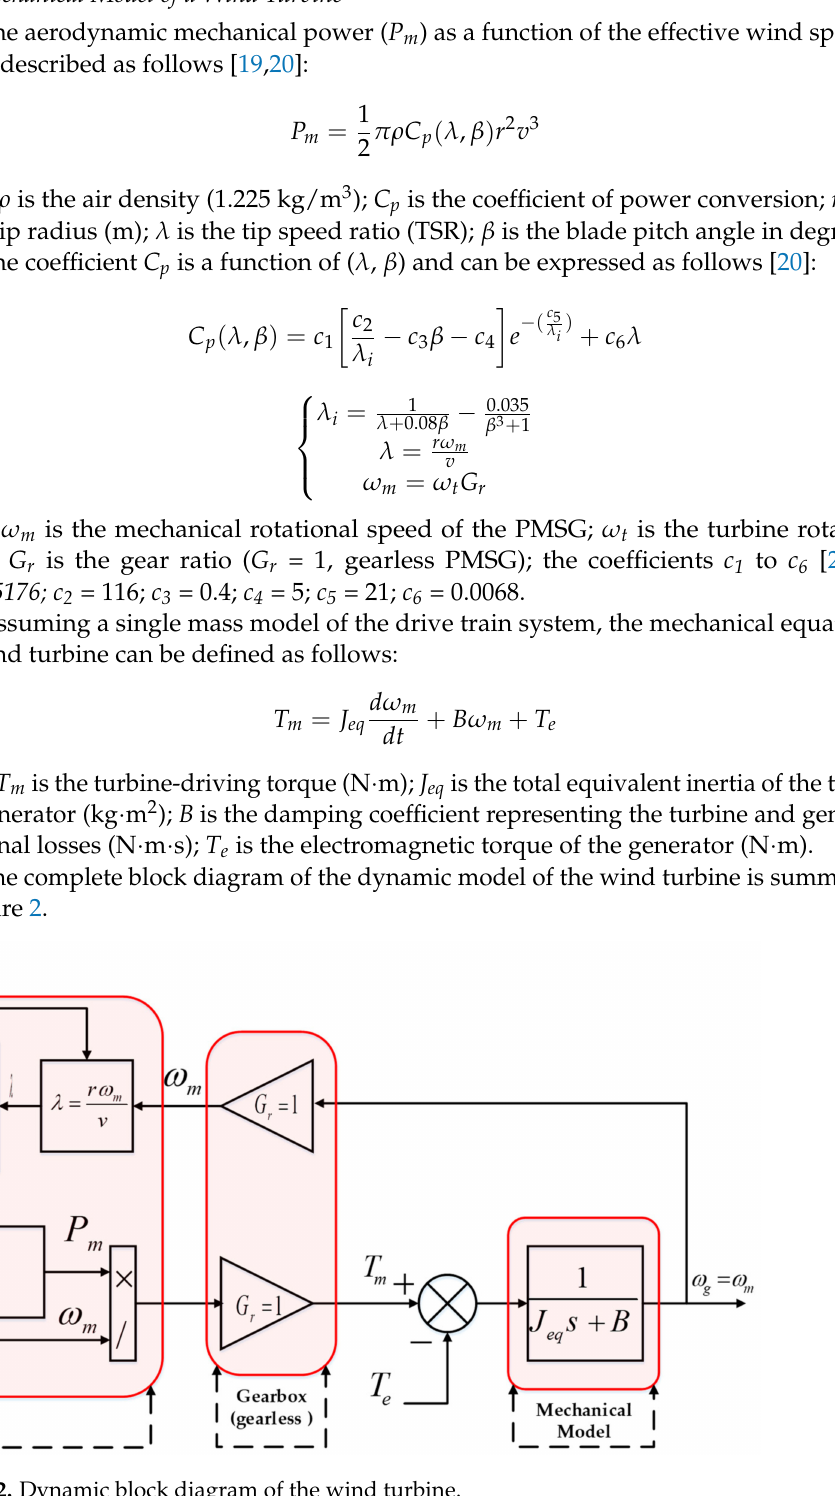
Figure 2. Dynamic block diagram of the wind